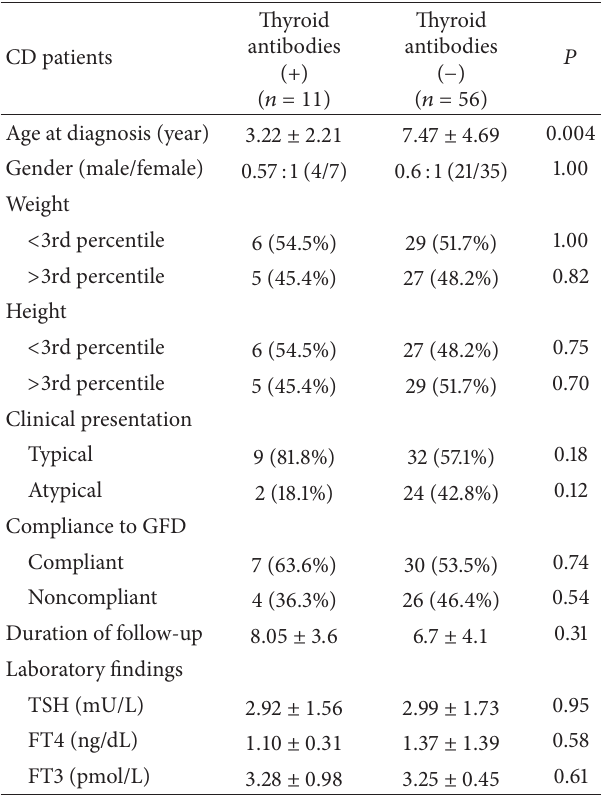
Table 1: Characteristics of pediatric patients with celiac